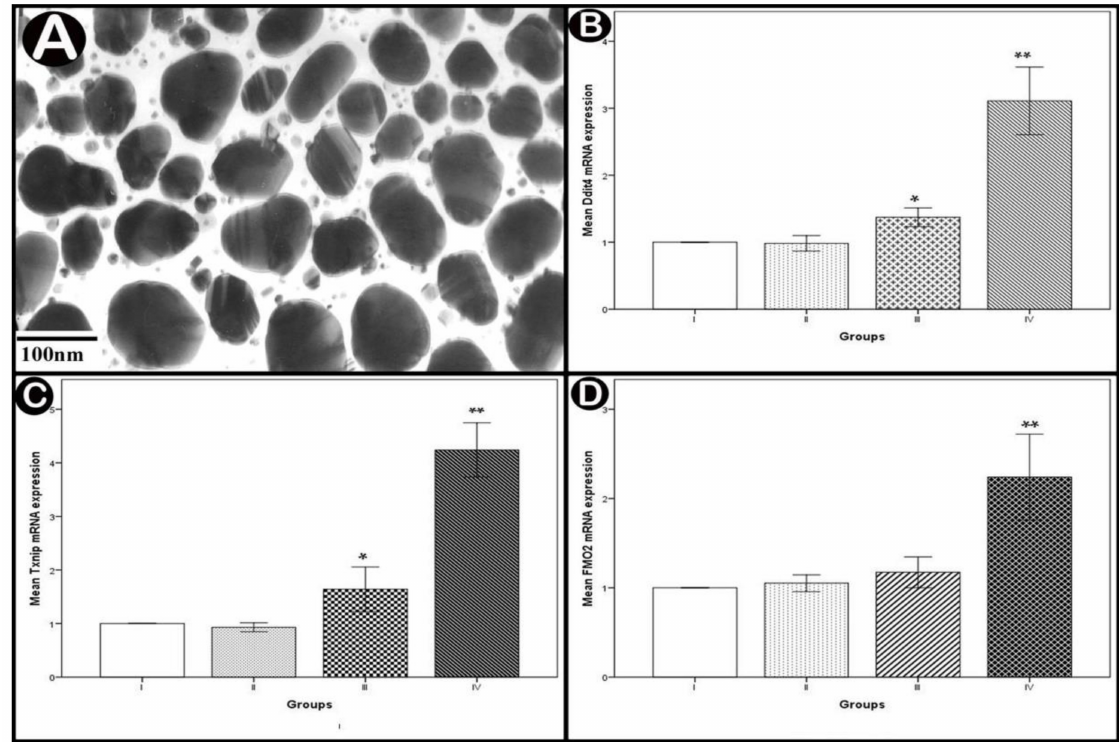
Figure 2. ( A ) TEM image showing average diameters of Ag-NPs. ( B – D ) real-time PCR analysis of mRNA expressions of DNA damage inducible transcript 4 ( Ddit4 ), thioredoxin-interacting protein ( Txnip ) and flavin containing monooxygenase 2 ( FMO2 ) in the cerebellar cortex. Values are expressed as mean ± standard deviation (X ± SD); *: Significant difference ( p < 0.05) and **: Highly significant difference (p < 0.001); n = 10